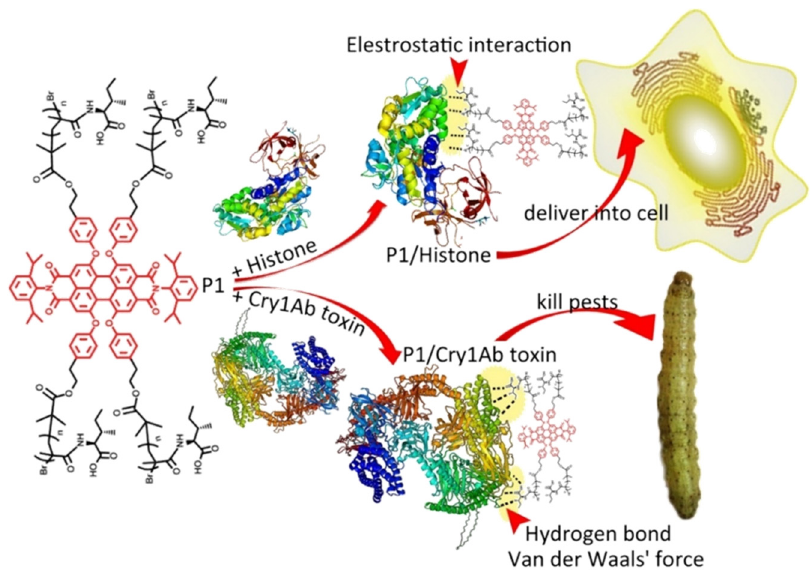
Figure 3. Schematic diagram of NCs-mediated delivery of Bt toxins for an effective control of unsensitive pests. Reproduced with permission. Adapted from Zheng Yang [54], with permission from the author.